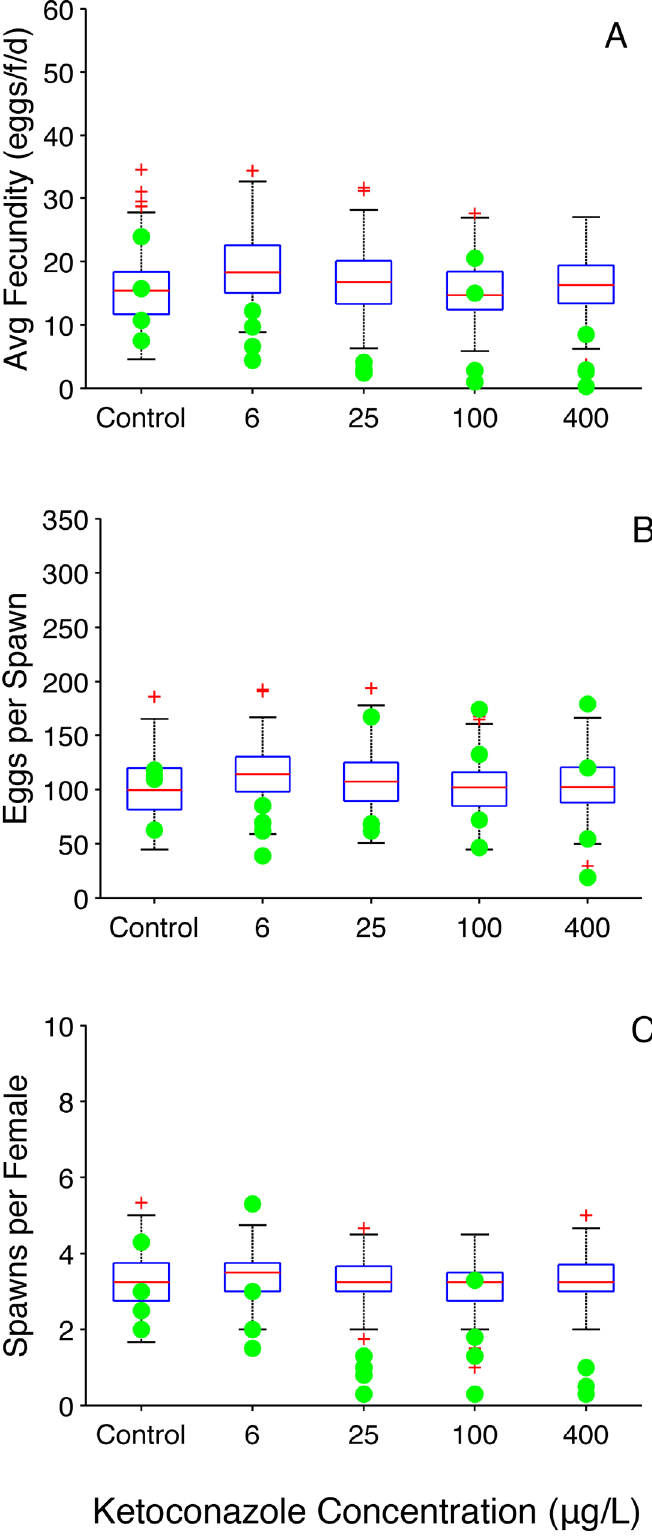
Fig 5. Ketoconazole Reproduction Metrics (group spawning design). (A) Average fecundity (eggs (cid:129) female -1 (cid:129) day -1 ). (B) Average number of eggs per spawn. A value of zero indicates that a fish did not spawn during the experiment. (C) Average number of spawns per female. Filled circles represent experimentally observed values [12]. Boxplots represent 200 OGDM-predicted values. In the boxplots, the PLOS ONE | DOI:10.1371/journal.pone.0146594 January 12,